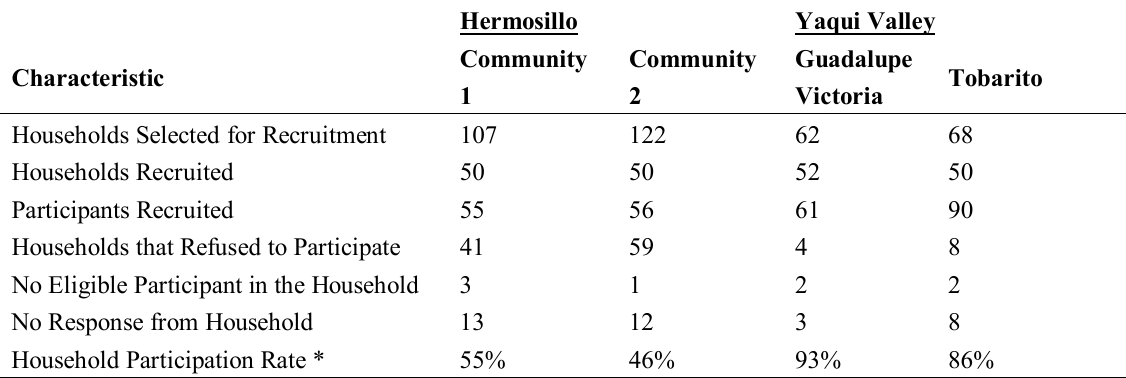
Table 2. Household Participation Rates from Door-to-Door Recruitment in Sonora, Mexico by